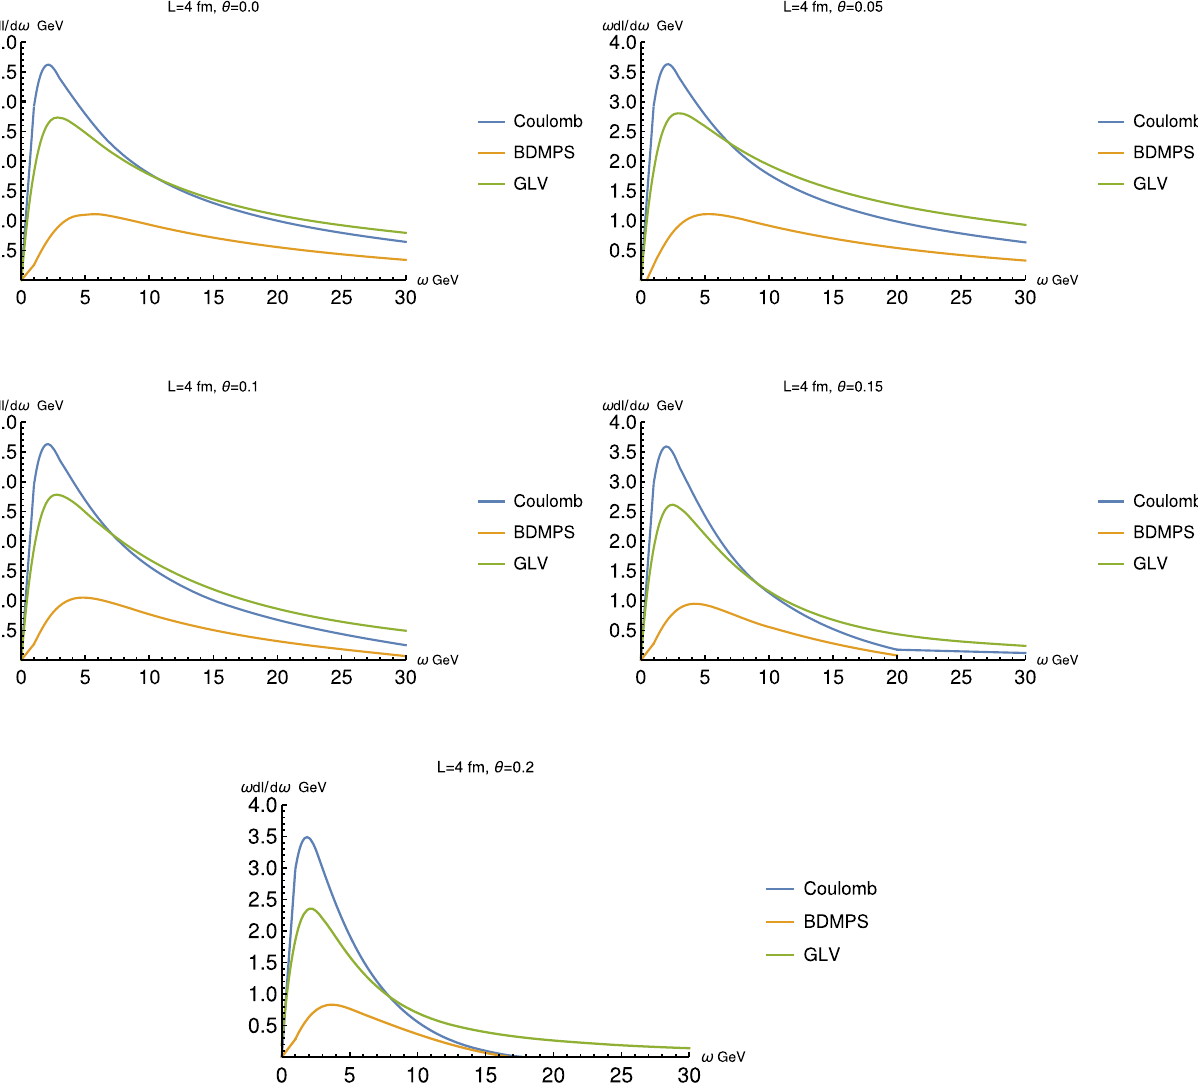
Fig. 4 The energy loss ω dI / d ω with Coulomb gluons for different θ = 0 , 0 . 05 , 0 . 1 , 0 . 15 , 0 . 2. The energy loss ω dI / d ω was calculated by integrating the corresponding angular distribution over k t in the finite interval of k t from k t = 0 to the kinematical bound k t ≤ ω . BDMPS